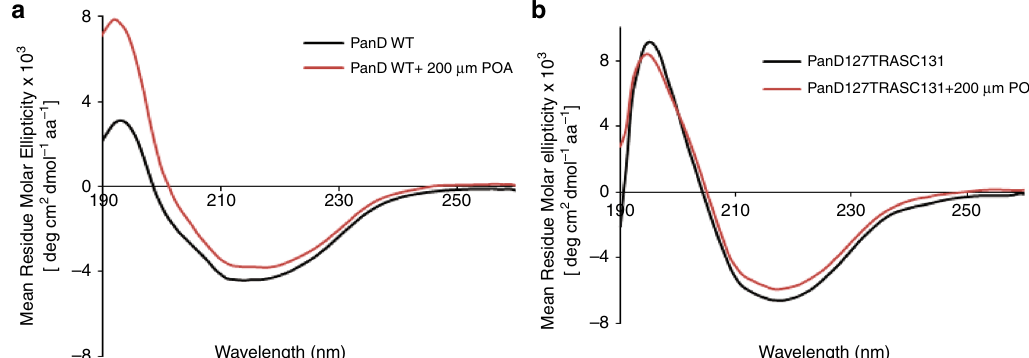
Fig. 7 Effect of POA on PanD WT and resistant mutant, non-POA binding PanD 127TRASC131 as determined by circular dichroism spectroscopy. a Far UV CD spectra of PanD WT without drug (black) and PanD WT with 200 μ M POA (red). The far UV spectrum of PanD WT revealed a peak at 195 nm and a broad minimum at 218 nm indicative of a signi fi cant presence of β -sheets. The CD spectrum of drug-free PanD suggests a secondary structural content of 4% α - helices and 37.8% β -sheets, consistent with the secondary structural content determined by the crystallographic structure of PanD (PDB ID: 2C45). The presence of 200 μ M POA caused an increase of mean residual molar ellipticity and decrease in breadth of the spectrum. b The far UV CD spectra of the PanD 127TRASC131 mutant protein in the absence (black) and presence (red) of 200 µ M POA. The CD spectra of the PanD 127TRASC131 mutant in the presence and absence of 200 μ M POA did not show the drastic effect at the 195 nm peak as observed for PanD WT shown in a . No change in the broader range from 190 to 210 nm was observed for the mutant protein in the presence of the drug. Only a minor decrease of mean residual molar ellipticity was detected at the 218 nm minima in the mutant spectrum after addition of 200 μ M POA. Two independent measurements were carried out and three spectra per sample were collected, yielding the same results. The results from a representative measurement are shown. These data show that POA causes a drastic change of the CD spectrum of wild-type PanD but has only minor effects on the CD spectrum of a POA-resistant mutant version of the protein. Source data are provided as a Source Data fi